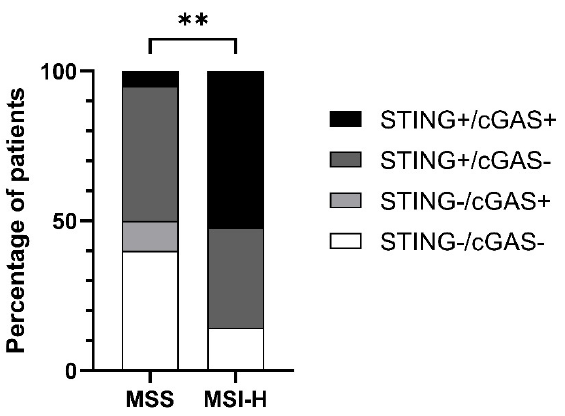
Figure 2. IHC analysis of STING and cGAS expression status in MSS and MSI-H. Chi-square test, ** p = 0.0050.